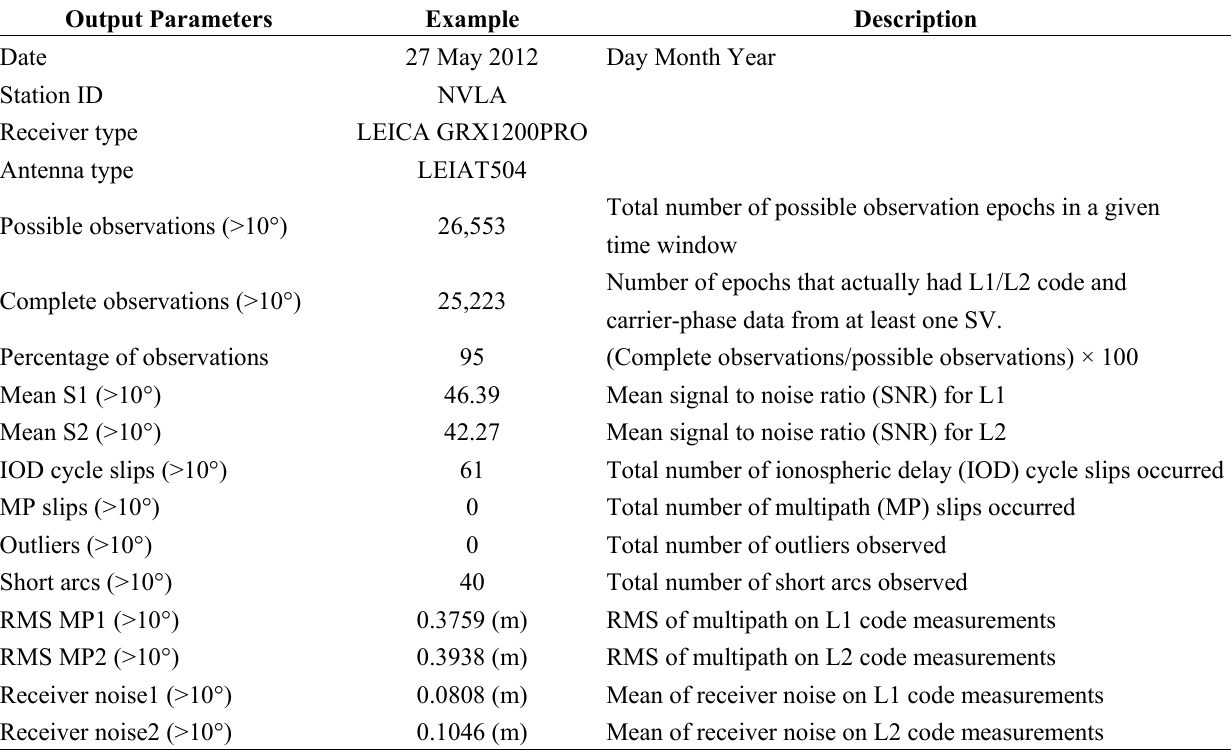
Table 2. Information of data quality parameters for Station NVLA on 27 May 2012.